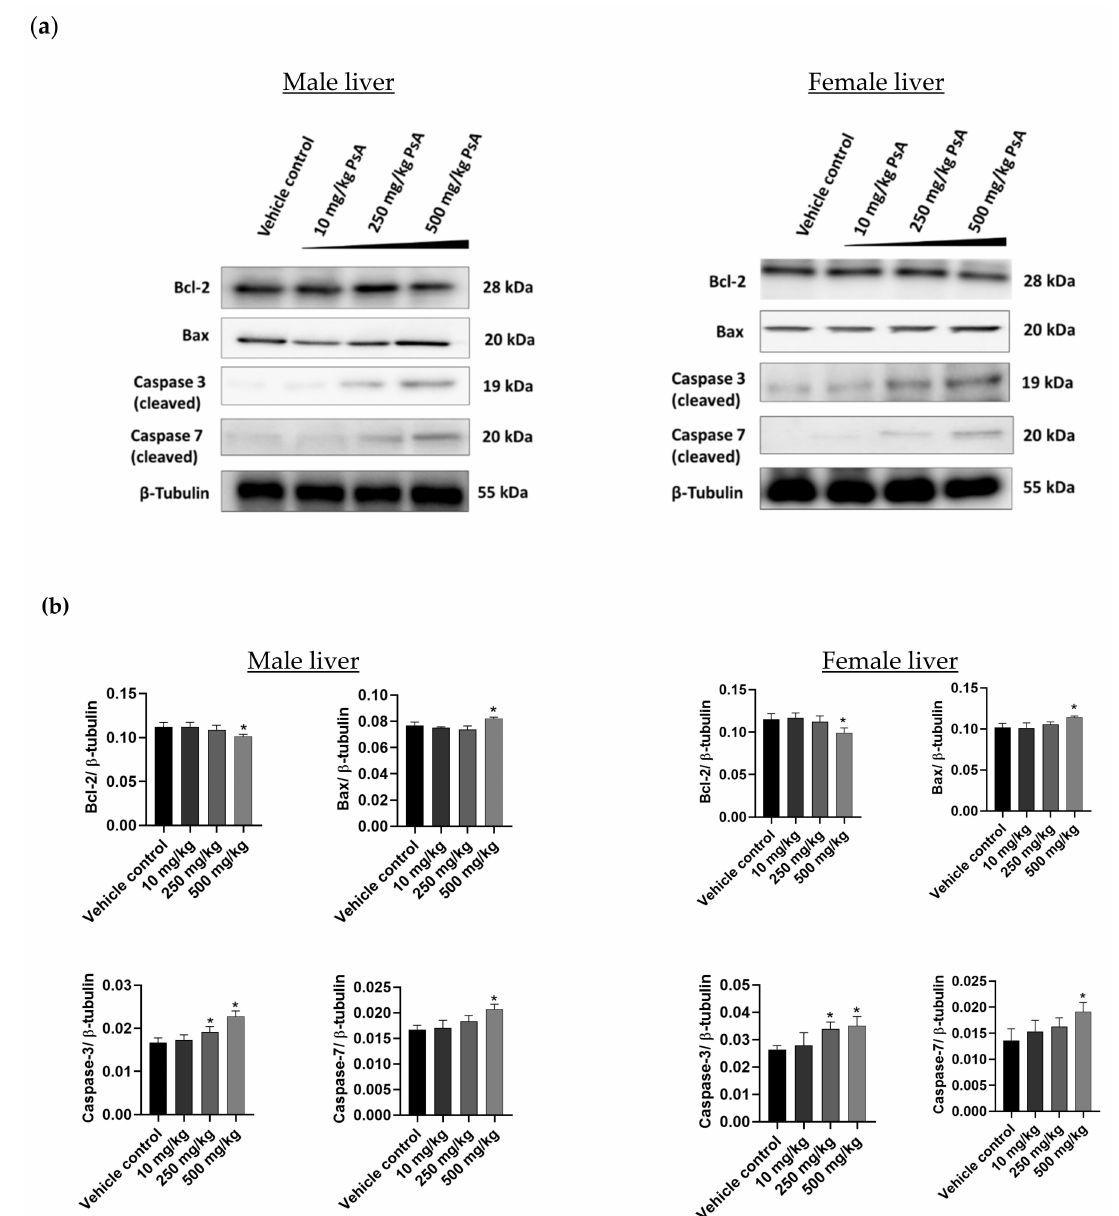
Figure 10. The effect of PsA treatments on the apoptotic markers in Swiss albino mice liver tissue lysates. ( a ) Immunoblots of Bcl-2, Bax, caspase-3, and caspase-7 protein expression 14 days post oral treatments of PsA and vehicle control in male and female mice. ( b ) Densitometric analysis of proteins expression normalized to β-tubulin 14 days post oral treatment of PsA and vehicle control in male and female mice. Data shown as mean ± SD of triplicate wells. * indicates a statistical significance at p < 0.05.